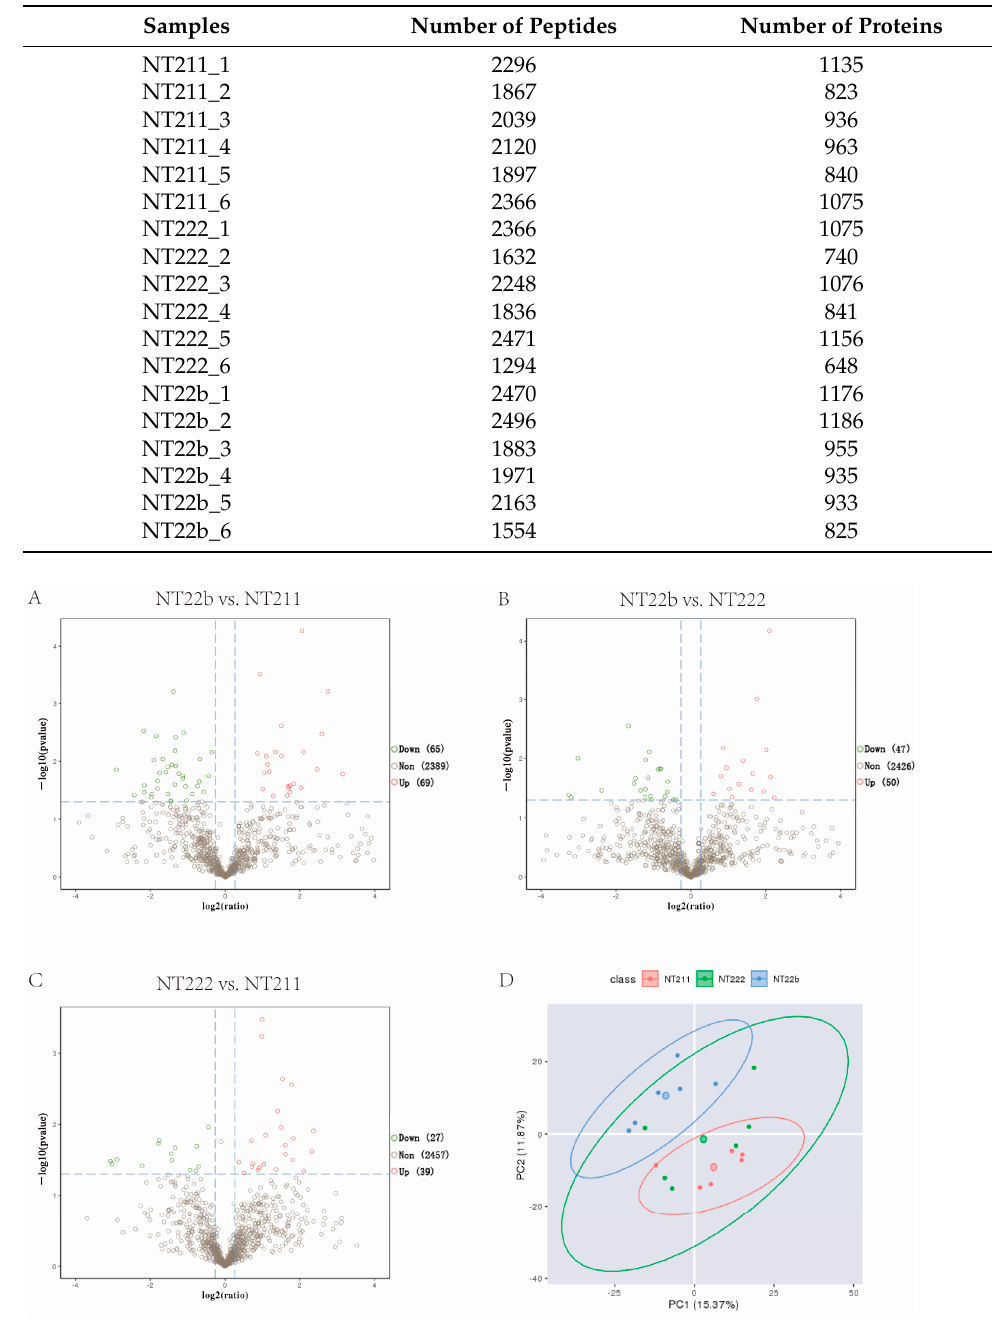
Figure 2. Microproteomic analysis of the three groups with different developmental fates. ( A ) Comparison of the differentially expressed proteins (DEPs) between the NT-22b and NT-211 groups. ( B ) Comparison of the DEPs between the NT-22b and NT-222 groups. ( C ) Comparison of the DEPs between the NT-222 and NT-211 groups. ( D ) Principal component analysis of the samples in the NT-211, NT-222, and NT-22b